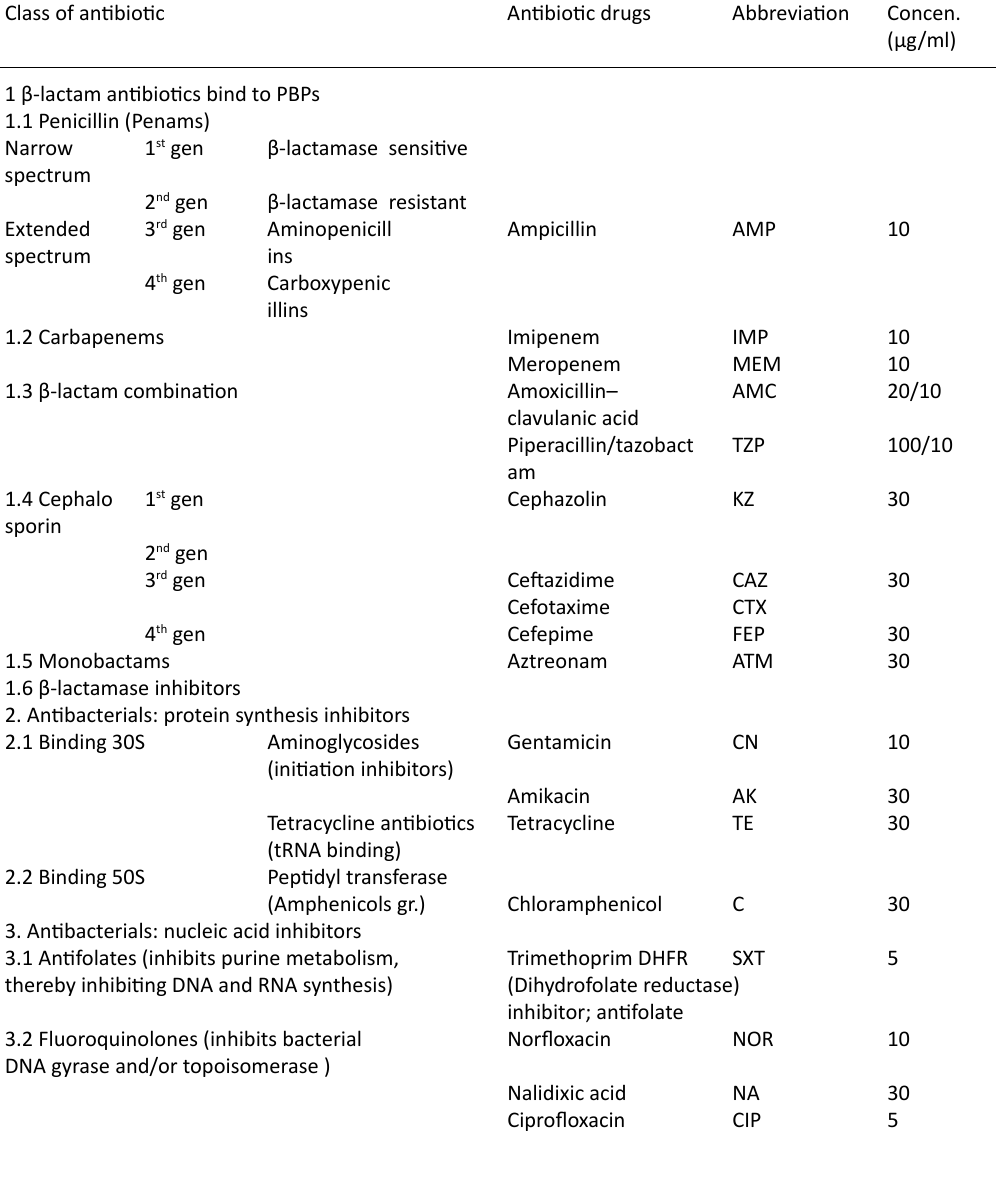
Table 1. List of antimicrobials and the concentration of drugs used to determine inhibition zones Class of antibiotic Antibiotic drugs Abbreviation Concen.